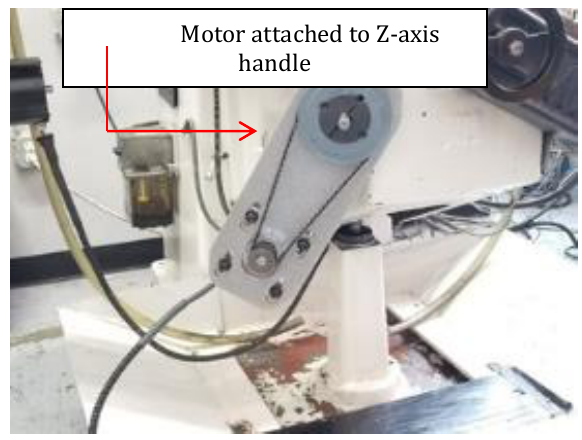
Source : PNGWING. (n.d.) Figure 4: Linear Actuator to knee based Z-axis movement